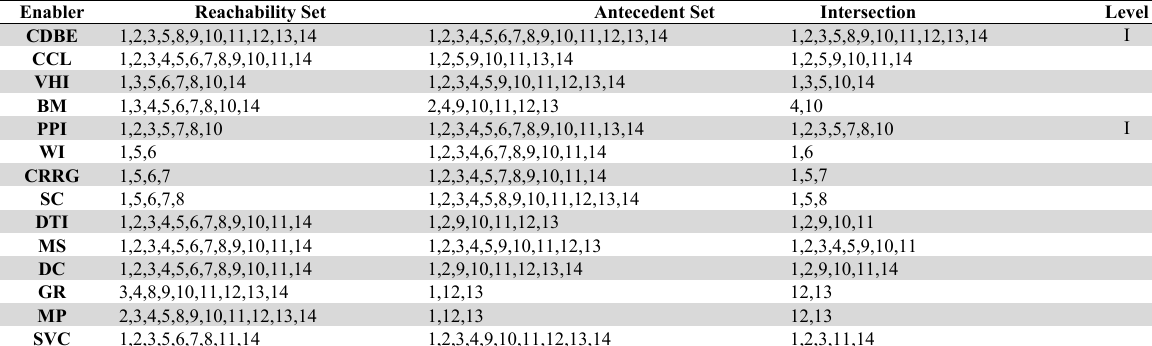
Level partitioning Iteration 1